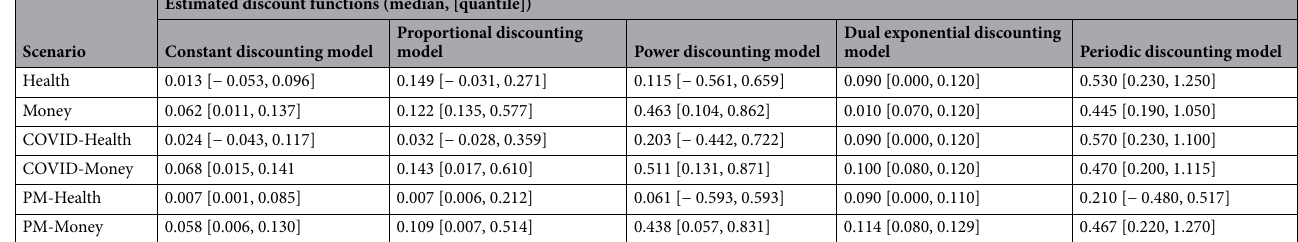
Table 3. Estimated discount functions. Remarks: (1) Estimated discount functions based on non-extreme subjects. (2) [ ] depicts 1st and 3rd quantile of discount factor.